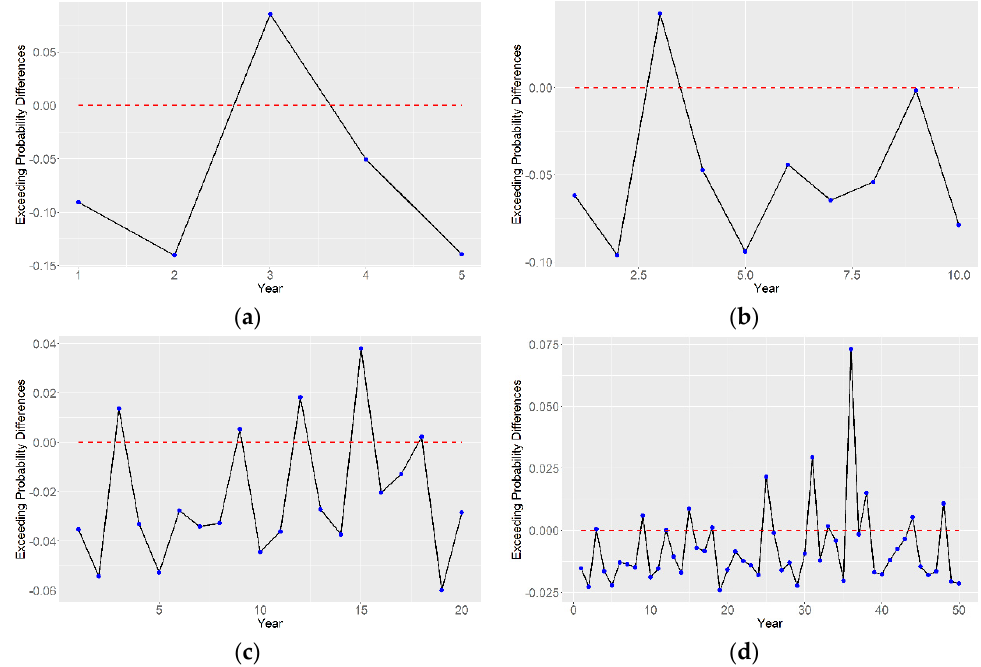
Figure 10. The annual exceedance probabilities differences of model LN C -3 compared to the model LN S corresponding to each design flood. ( a ) 5-year design flood; ( b ) 10-year design flood; ( c ) 20-year design flood; ( d ) 50-year design flood.